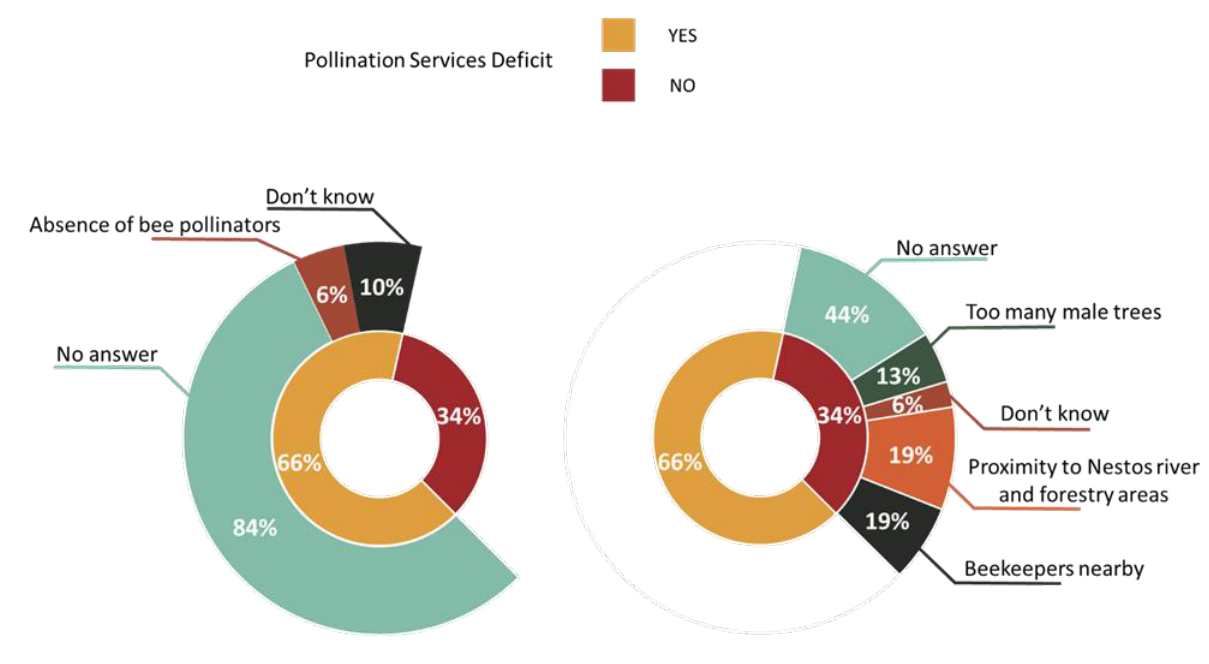
Figure 5. Farmers’ perception towards pollination services deficit.